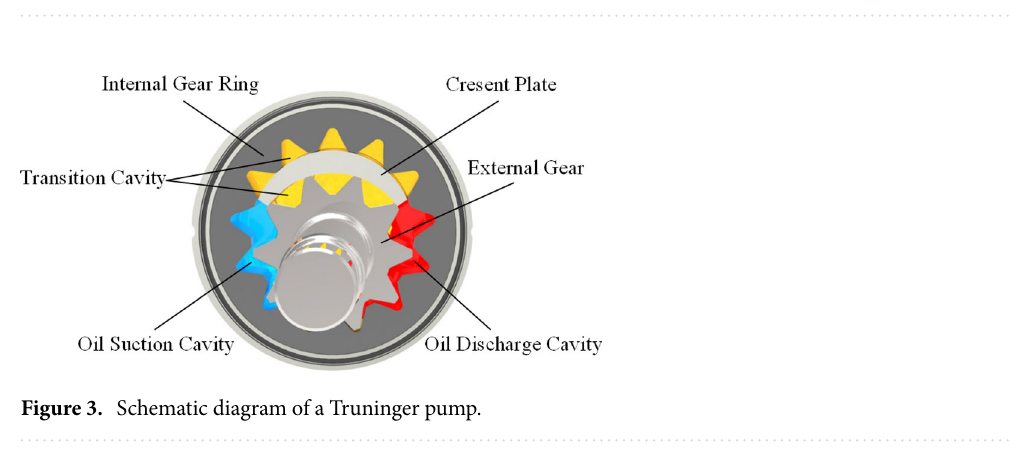
Figure 2. Photographs of the components of the pump.